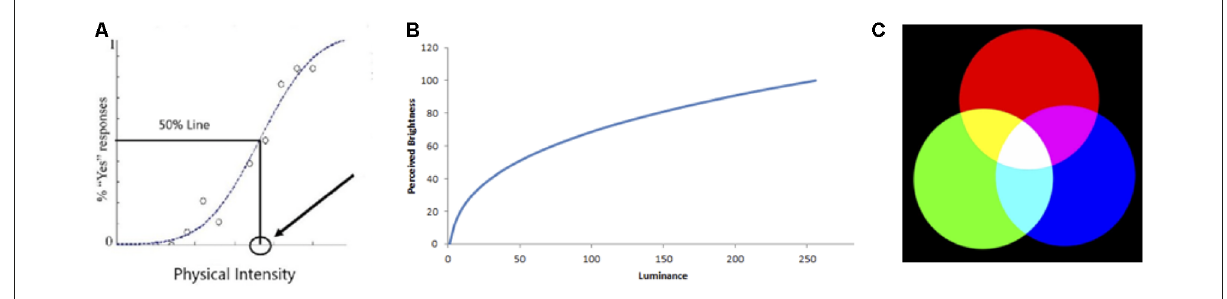
FIGURE5 Examples of (A) thresholds, (B) non-linearities, and (C)